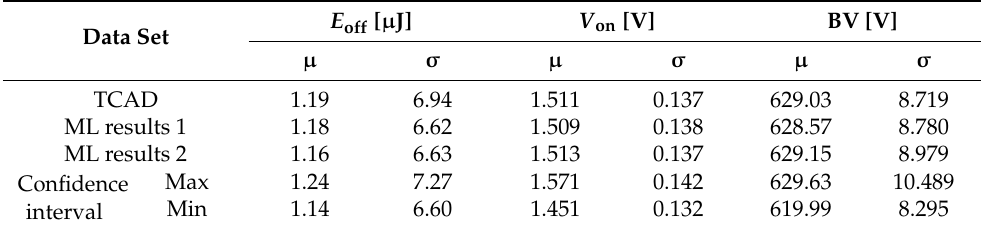
Figure 6. Test data set from TCAD versus data set predicted by ML model. There are ( a ) E off - V on , ( b ) BV- V on , and ( c ) E off -BV. Note that black-colored circles, red-colored triangles, and blue-colored reverse triangles indicate TCAD sample, ML sample 1, and ML sample 2, respectively. E off ( g ), V on ( h ), and BV ( i ) according to doping concentration are plotted in 3D, and errors are shown in ( d – f ), respectively. Each label is min-max-scaled, and the ideal criterion is set as the red diagonal line. E off ( j ), V on ( k ), and BV ( l ), the results of ML models tested with multiple samples, inherit the trends of E off ( g ), V on ( h ), and BV ( i ) that were approximately expected as points. Table 2. Mean and standard deviation of the performance